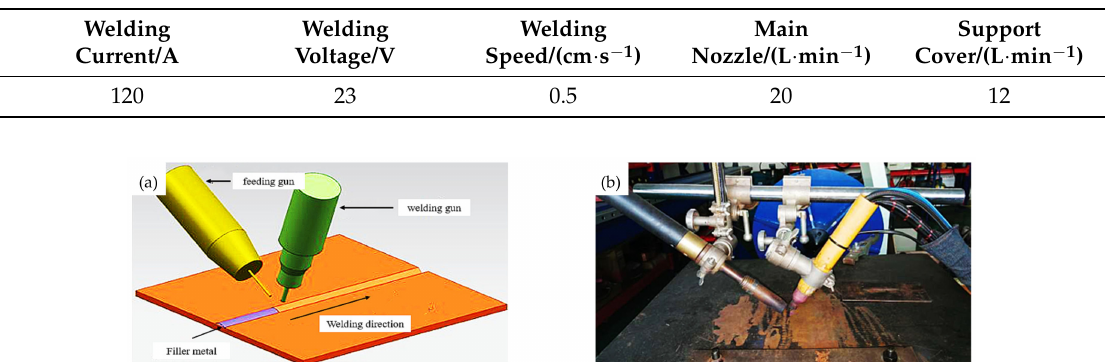
Table 2. Welding parameters of manual tungsten pole argon arc welding.